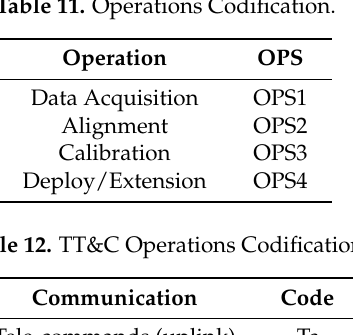
Table 11. Operations Codification.